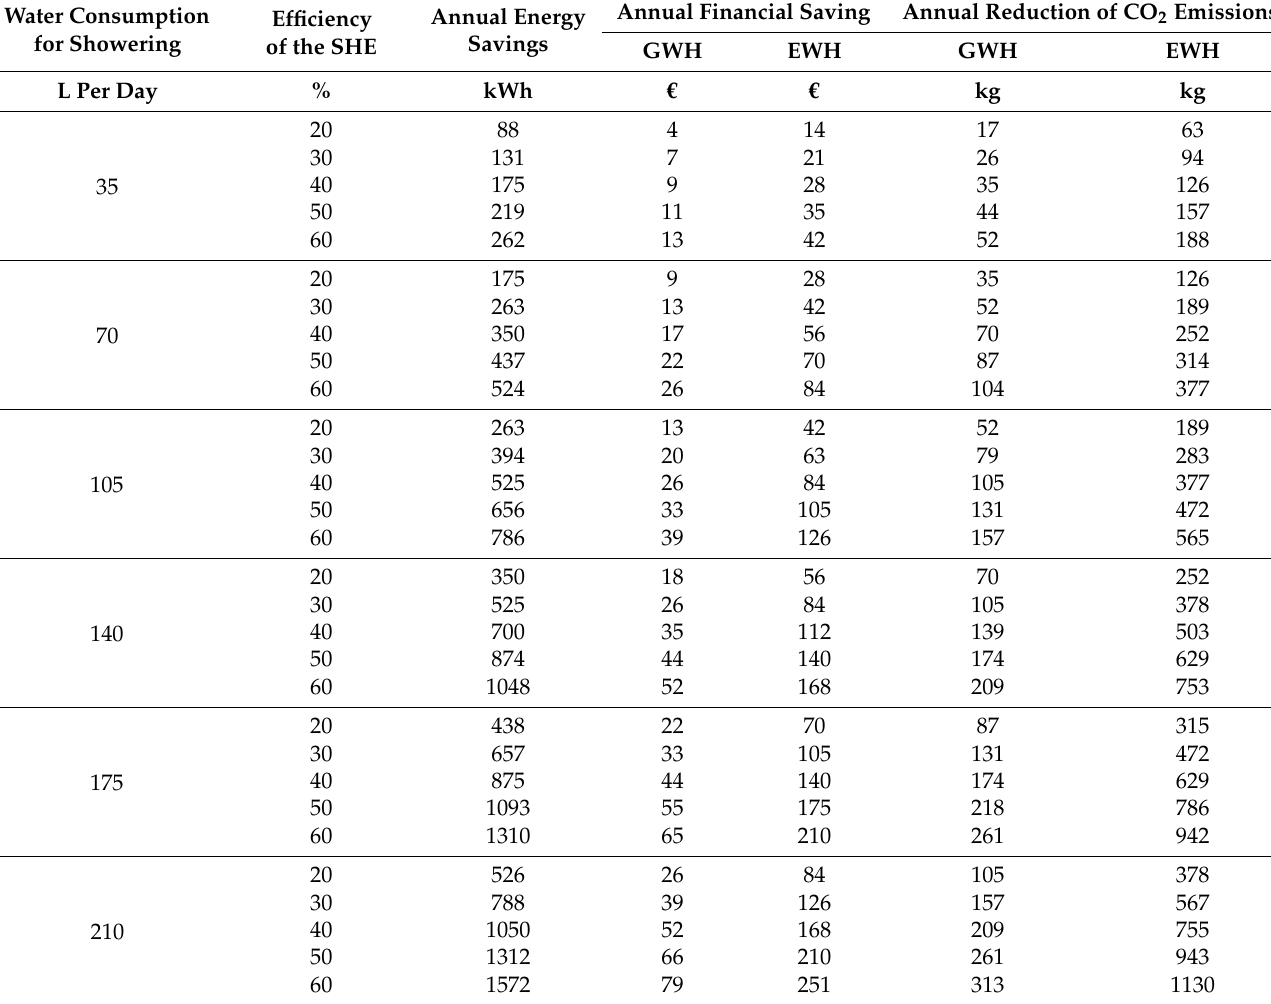
Table 2. The effects of using a shower heat exchanger in a single-family building (SHE—shower heat exchanger, GWH—gas water heater, EWH—electric water heater). Water Consumption for